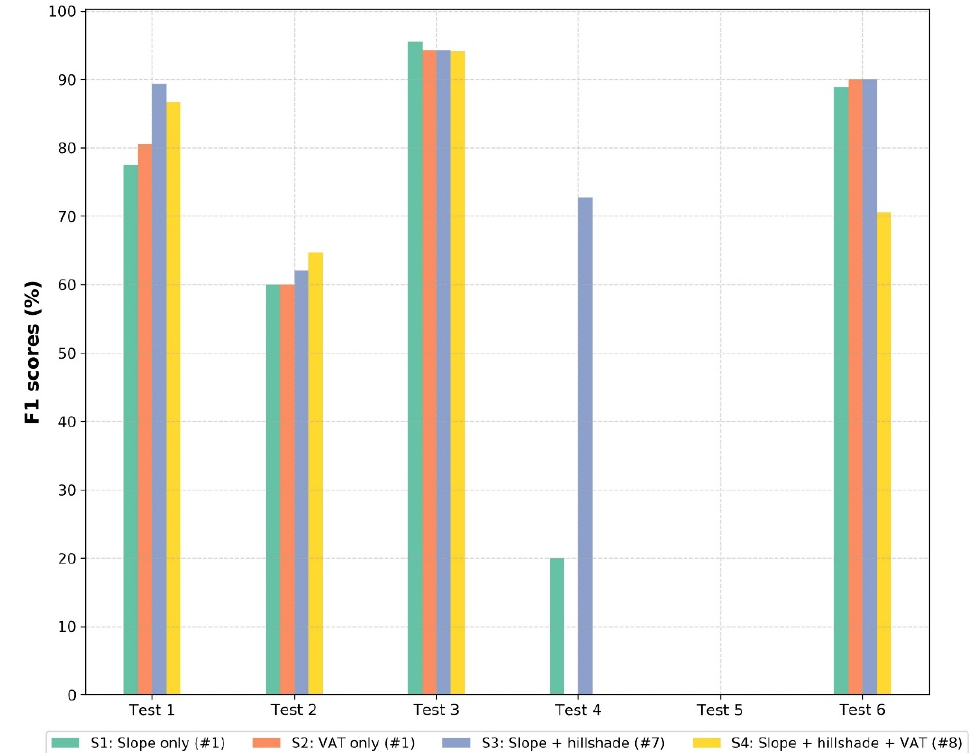
Figure 5. F1 score results for input scenarios by six test regions. (input scenarios—S1: single slope raster, S2: single VAT raster, S3: 7 bands composition with slope and hillshades rasters, S4: 8 bands composition with slope, hillshades, and VAT rasters; # refers to the number of rasters for input im- age).